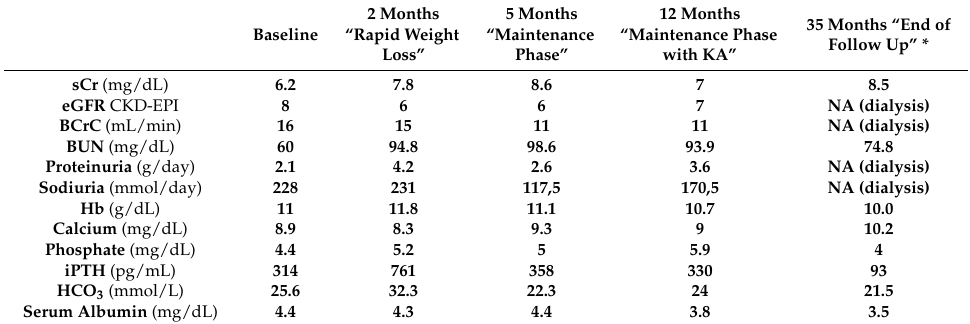
sCr: serum creatinine; BCrC: creatinine clearance on 24-h urine collection; eGFR: estimated glomerular filtration rate calculated using CKD-EPI formula; BUN: blood urea nitrogen; Proteinuria: proteinuria excretion on 24-h